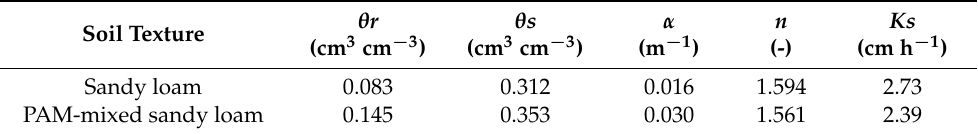
Table 5. Hydraulic parameters of sandy loam and PAM-mixed sandy loam.